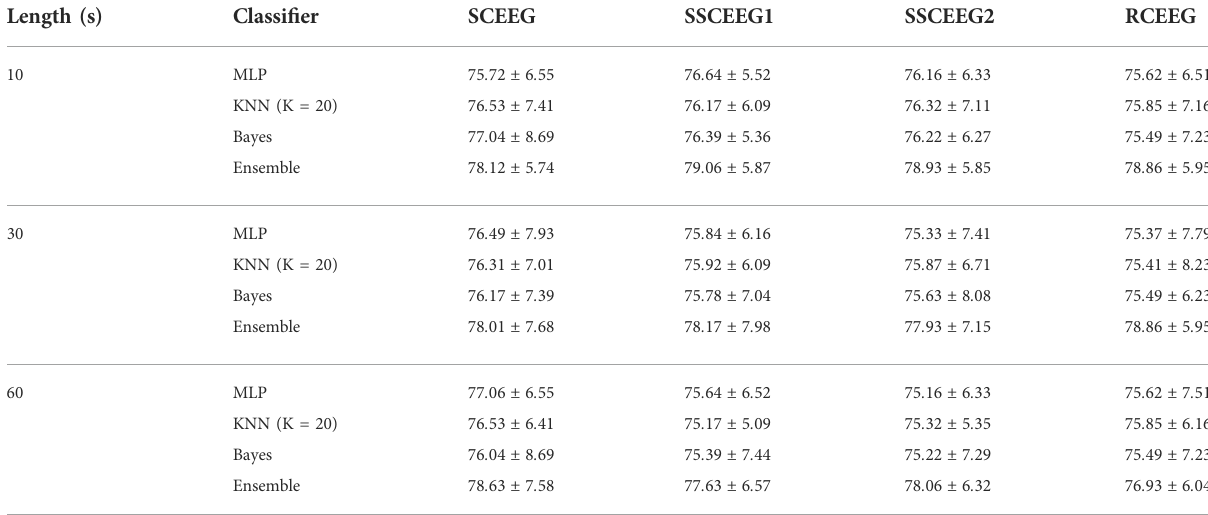
TABLE 3 Average and standard deviation of classi fi cation accuracy in the 6-class scenario using all of the datasets, including simulated, semi- simulated and real EEGs. Length